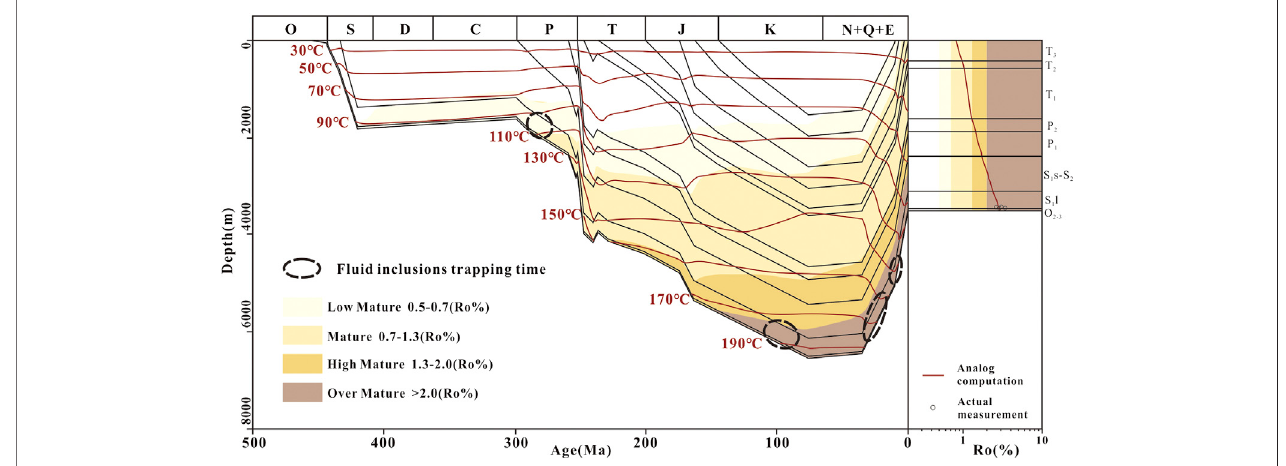
FIGURE 10 | Burial-thermal evolution history of Longmaxi shales of well N228 in the deep depressional area of the Changning area.